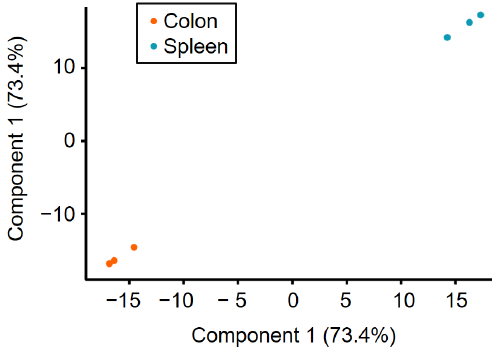
Figure 3. Scatter plot visualization of three murine colon (orange) and spleen (blue) tissue samples, showing component 1 against component 1 of PCA. The visualized data is based on 501 proteins with quantitative information for all samples (see Supplementary Table S3).